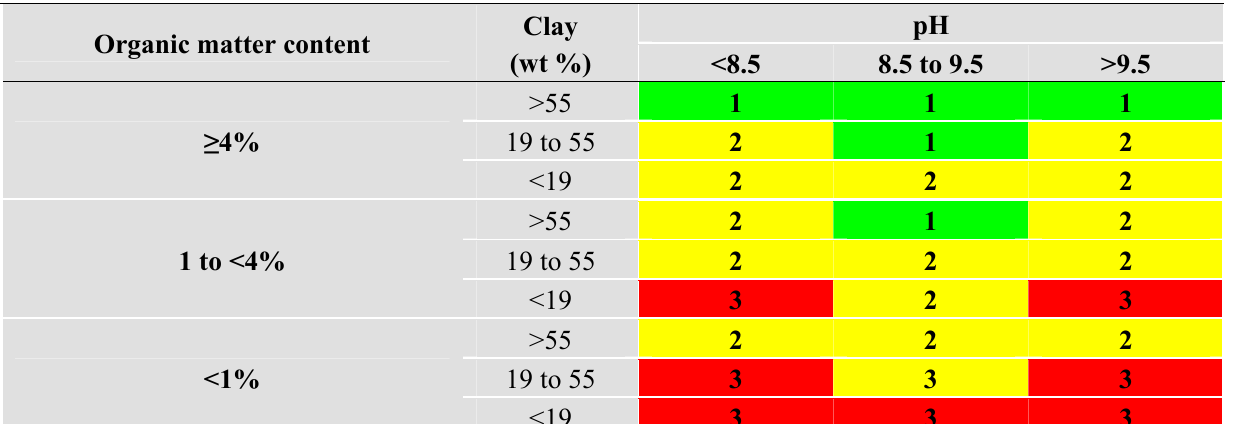
Table 9. Assessment matrix for the estimation of the sensitivity towards the mobilization of